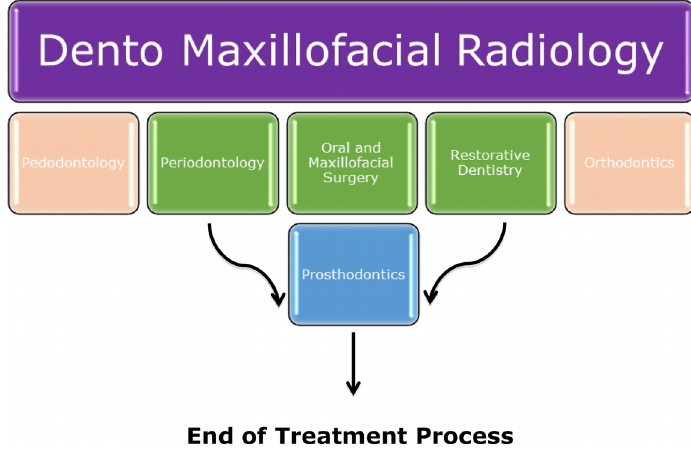
Figure 2. Clinics process flow